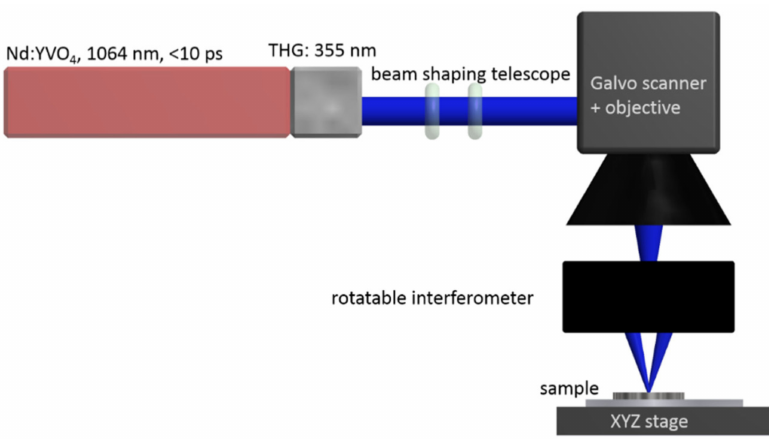
Figure 1. Setup for di ff ractive laser structuring of the implants. The galvo scanner moves the beam across the sample. The rotatable interferometer produces the basic line structures which can be overlaid with arbitrary angles by repeated radiation in order to produce more complex periodic